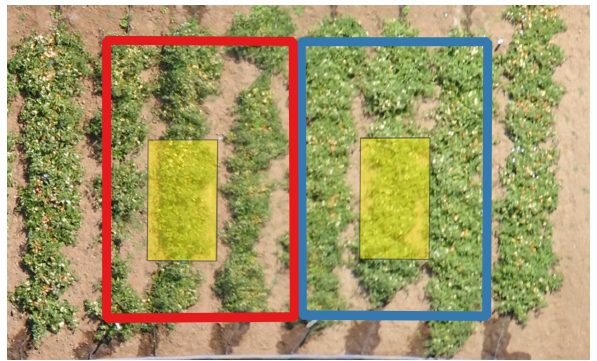
Figure 4. Harvest strategy: 2 m on a line in the middle row of each of the